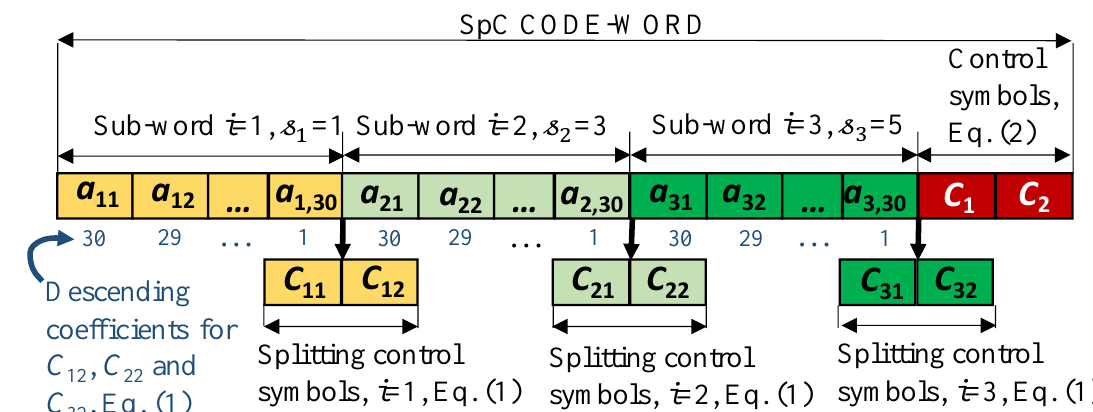
Figure 1. A code-word of the splitting code, m = 5, p M = 31, and |S| = 3 for sub-words comprising 30 symbols each. The splitting control symbols, C 1 i and C 2 i , I = 1, 2, 3, are byproducts of control symbol formation; the sub-words and splitting control symbols marked by the same color create independent embedded sub-code-words of the splitting code.